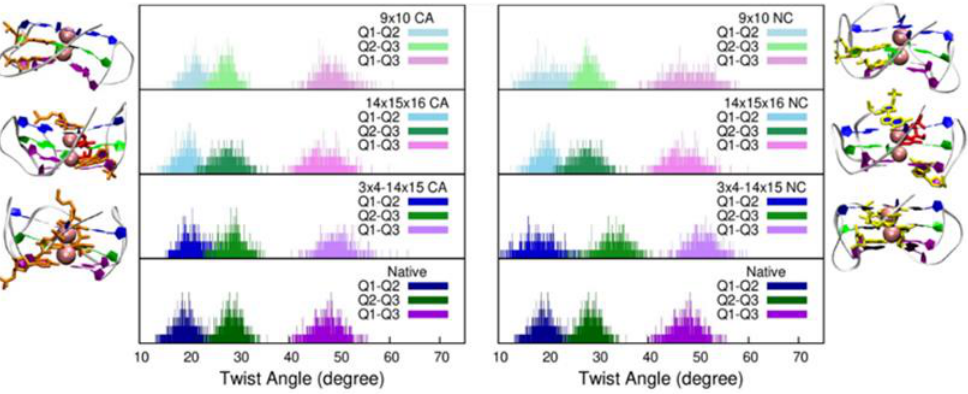
Figure 4. Distribution of the twist angle for representative DNA damaged structures (upper panels) compared to those of the native structure (bottom panels). compared to those of the native structure (bottom